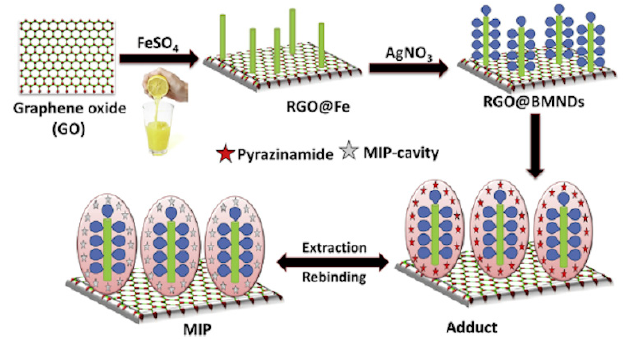
Figure 15. Graphical representation for the synthesis of imprinted reduced graphene oxide@bimetallic nanodendrites. Reproduced from [151] with permission from Elsevier.